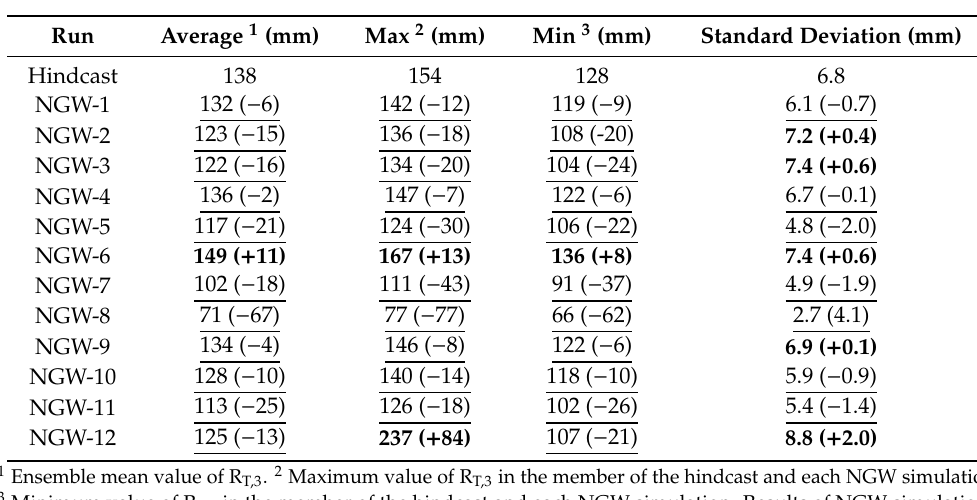
Table 5. Total rainfall averaged for D03 (R T,3 ).